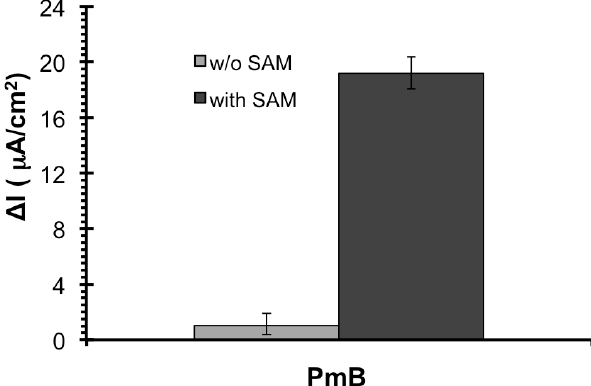
Figure 7. E ff ect of the SAM in the ligand immobilization. Change of the measured current due to the PmB immobilization with and without SAM.